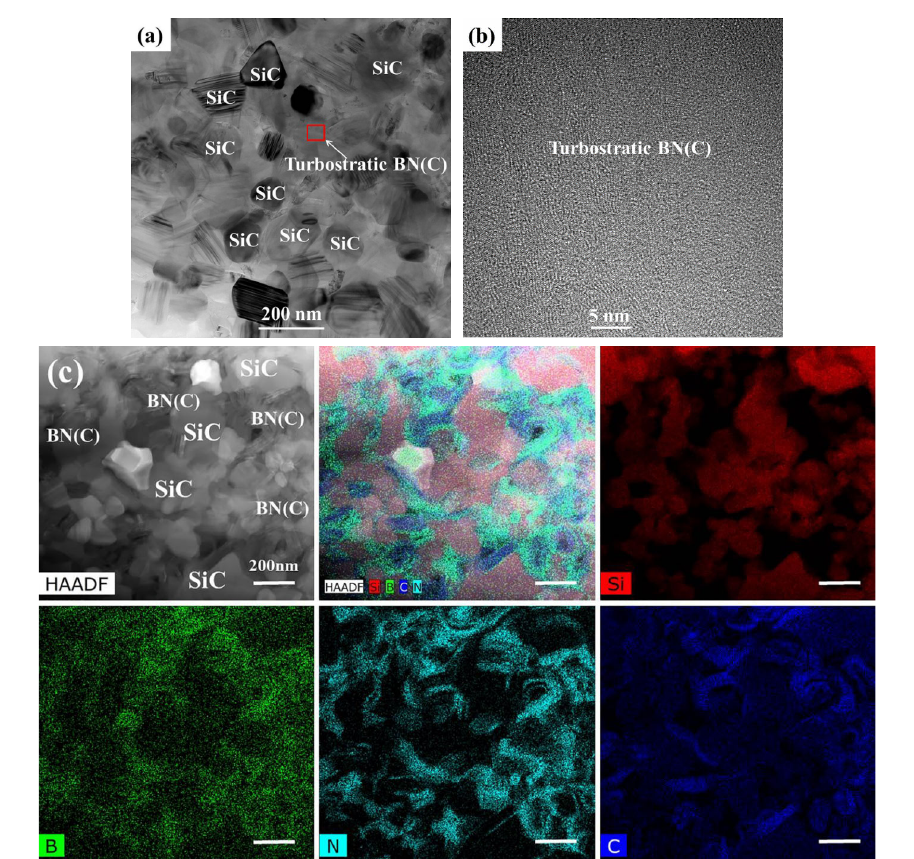
Fig. 7 TEM microstructures of specimen SCNT0; (c) is reproduced with permission from Ref. [13], © Elsevier Ltd and Techna Group S.r.l.